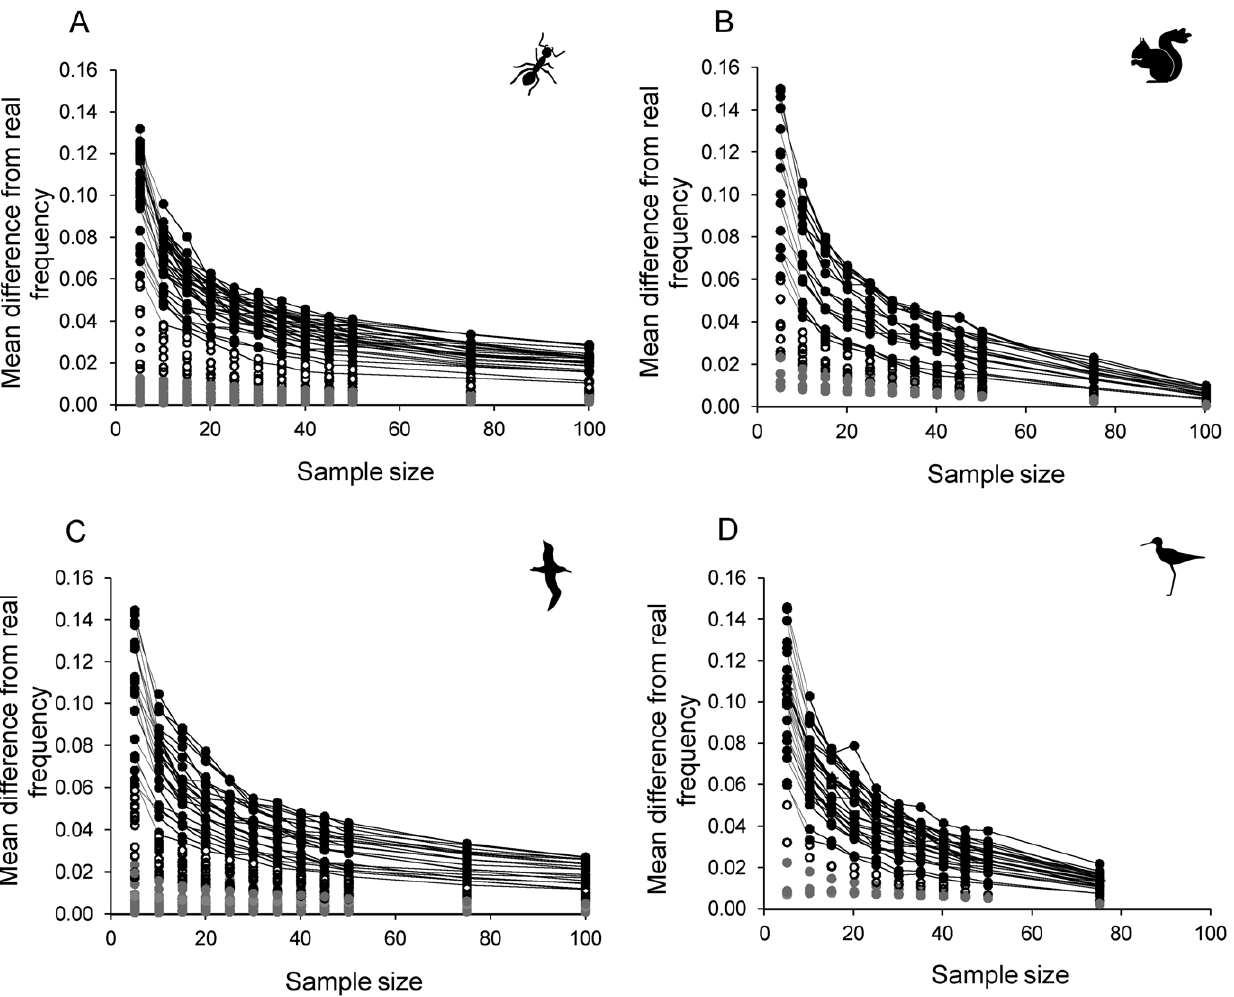
Figure 2. Impact of allele frequency and sample size on the accuracy of mean sample allele frequency. Mean difference from the real allele frequency for each sample size (of the 100 random replicates per size) for A) the ant dataset, B) the squirrel dataset, C) the albatross dataset and D) the kakı¯ dataset. Black circles represent alleles with a real frequency $ 0.05 (data for the same allele at different sample sizes linked by a line), white circles represent alleles with a real frequency between 0.05 and 0.01, and grey circles represent alleles with a real frequency #